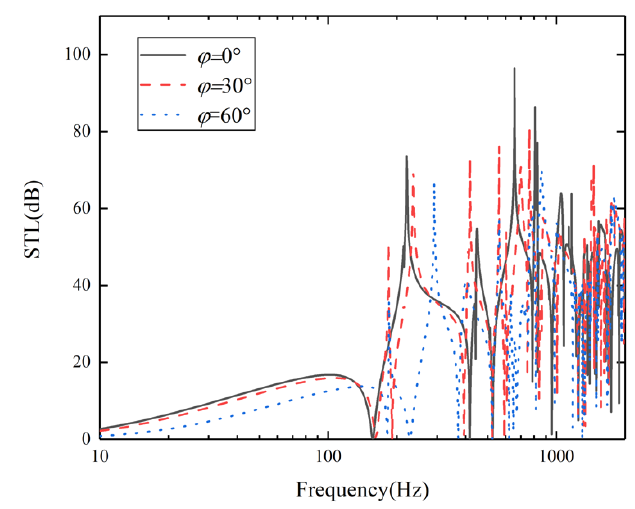
Figure 11. STL at different incident angles.